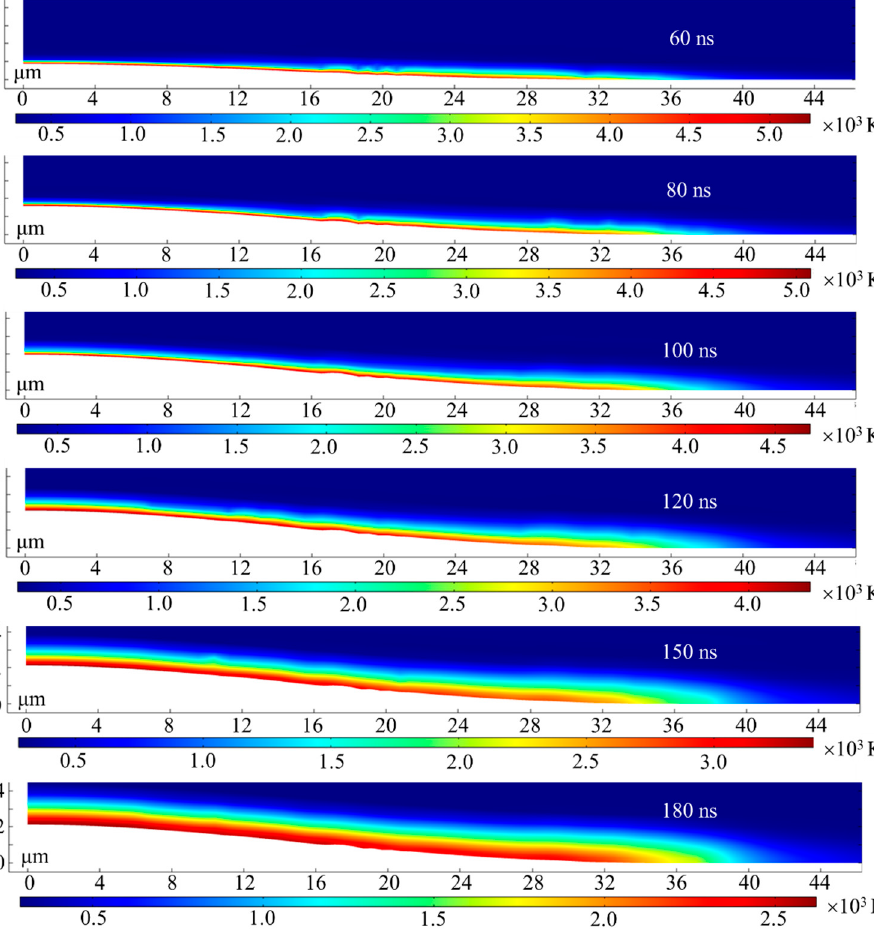
Figure 3. Contour plots of ablation morphology and temperature for the simulated ablation for laser fluence of 19.3 J/cm 2.